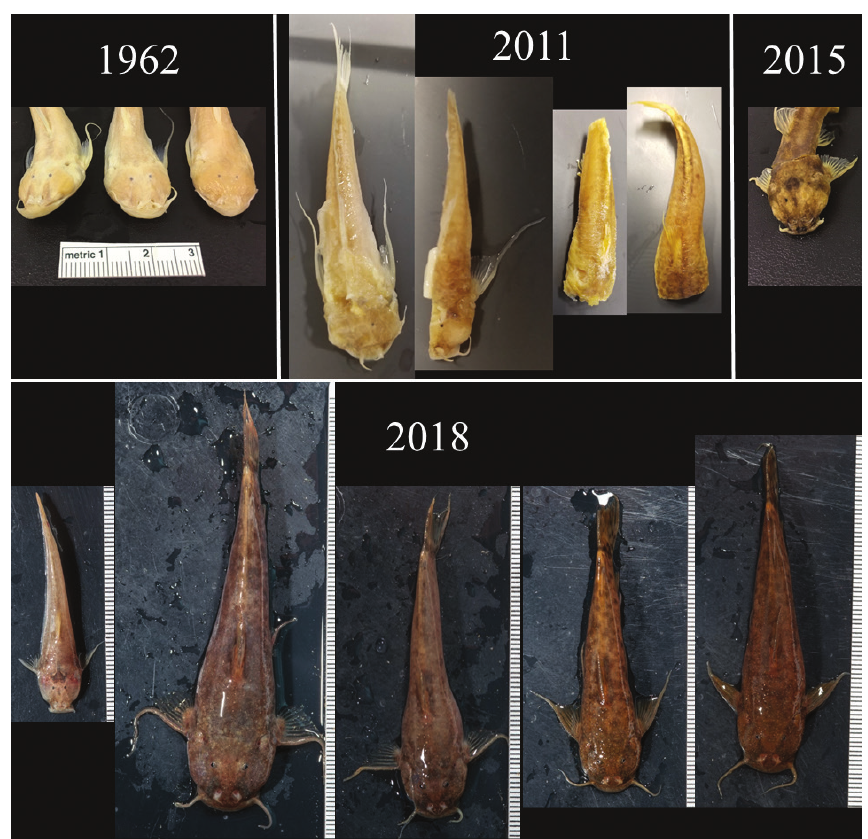
Figure 1. Specimens collected in 1962 (holotype, and paratypes of A. pholeter from left to right) 2011, 2015 and 2018. Notice that there is a progressive reduction in the expression of troglomorphic features. After 2011 the skin was distinctly more pigmented and the barbels and fins were shorter. Eyes are also embedded under a thinner dermal layer of skin. In 2011 the population was highly